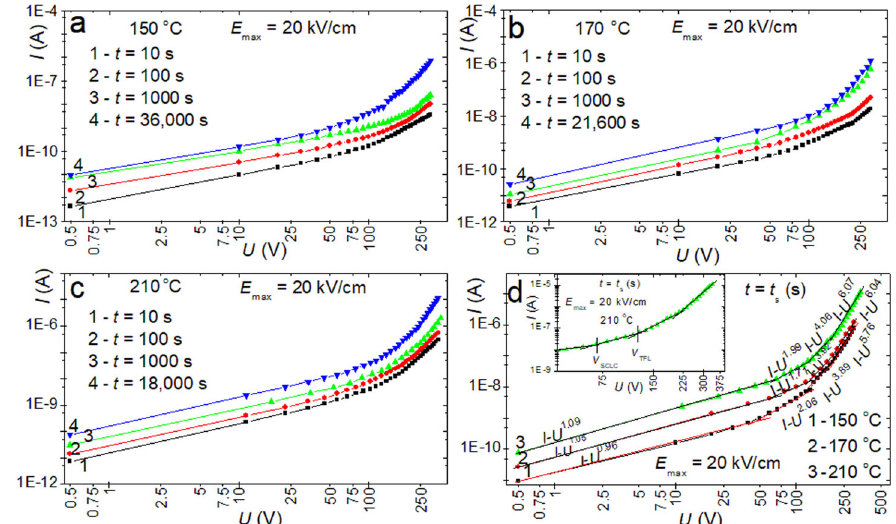
Fig. 3 I – U characteristics of NBT ceramics were measured several times (a–c) after an electric field of varying strength had been applied, and (d) under steady-state current conditions. In the inset in (d), the voltage at which the transition from ohmic behavior to space-charge limited current occurs ( V SCLC ) and the trap-filled limit voltages ( V TFL ) at temperature 210 ℃ are